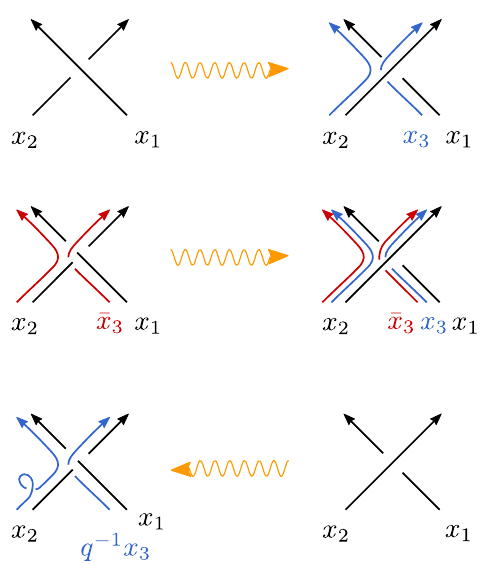
Figure 6. Starting from the standard unlinking based on the skein relation (upper picture), we add a red anti-disk on both sides (middle picture) and then the disk/anti-disk pair is annihilated, whereas the red anti-disk on the left can be exchanged for a regular blue disk with self-linking and 4-chain intersection (lower